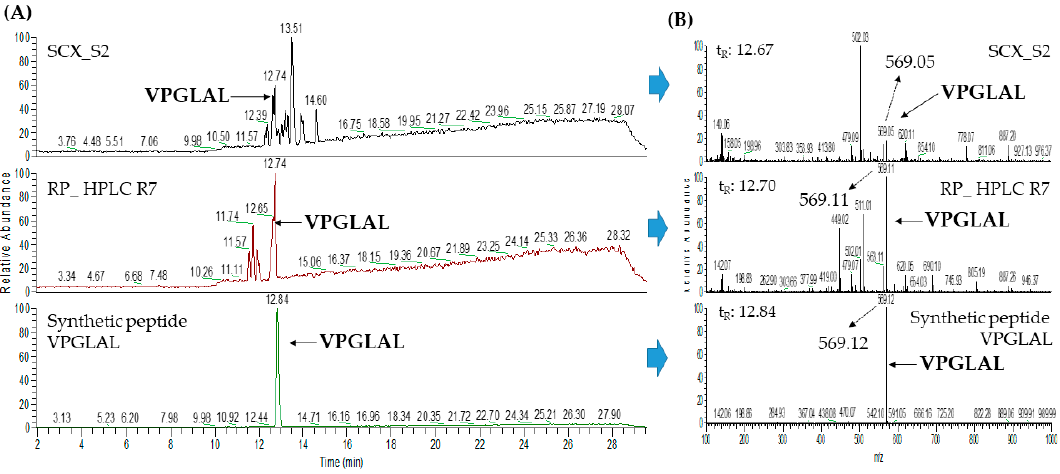
Figure A8. ( A ) LC–MS chromatograms of SCX S2, RP R7, and the synthetic peptide VPGLAL, ( B ) MS spectra of VPGLAL originated from fraction SCX S2 ( m / z 569.05, t R 12.67 min), fraction RP R7 ( m / z 569.11, t R 12.70) and synthetic VPGLAL ( m / z 569.12, t R 12.84).